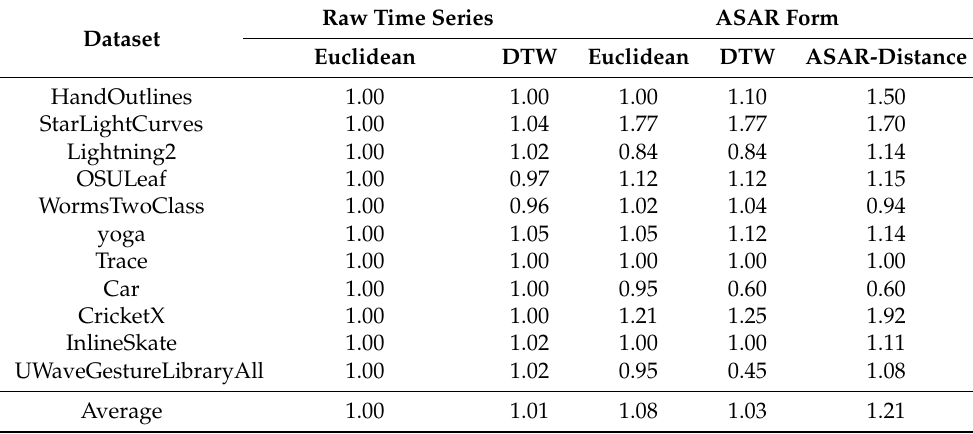
Table 3. F-measure relative results for hierarchical